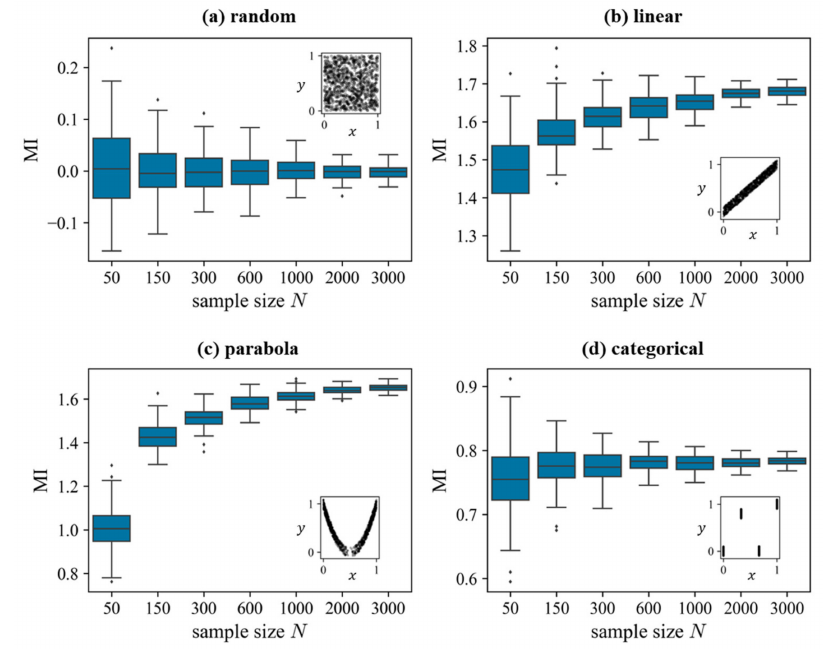
Figure A1. Variation of ˆ I g ( x ; y ) with increasing sample size N